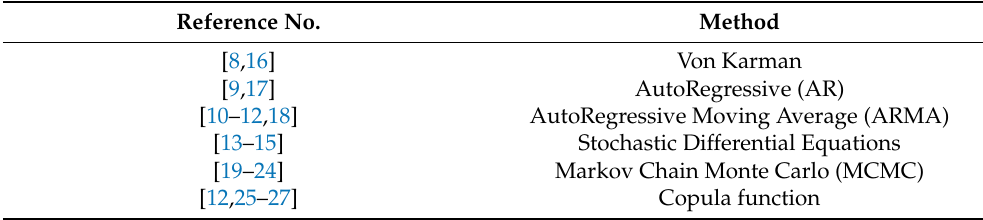
Table 1. Wind power output models.